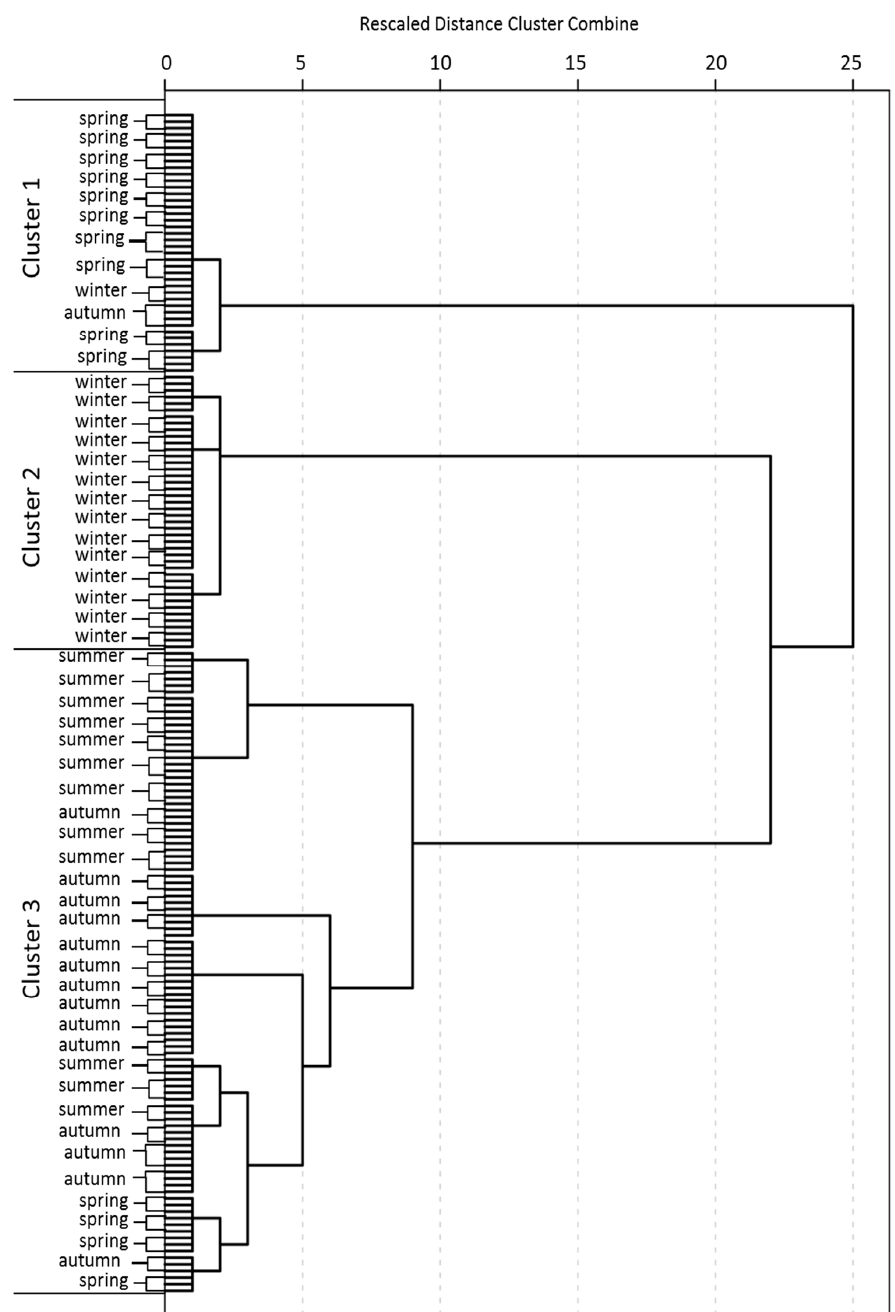
Figure 5. Dendrogram showing clustering of seasons according to Ward’s method using squared Euclidean distance.